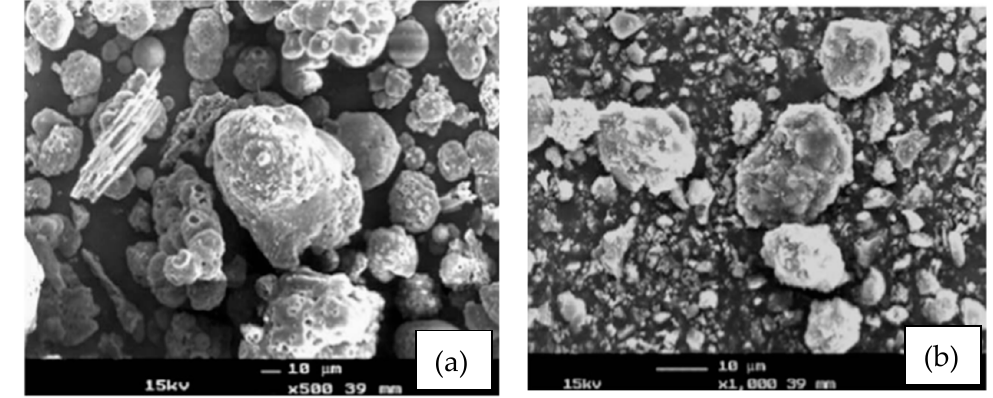
Figure 9. SEM of ( a ) fresh and ( b ) grounded POFA [87].